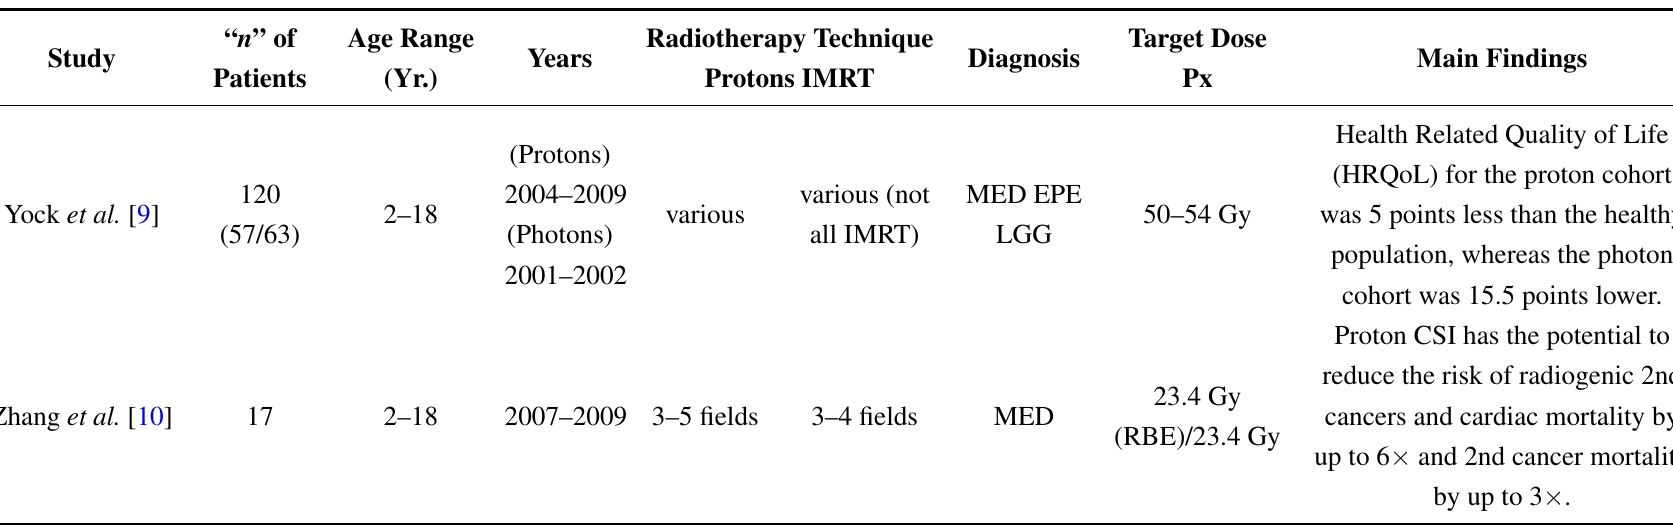
Table 1. Description of Proton versus IMRT patient outcome studies on paediatric CNS patients. [ Key: EPE—Ependymoma, LGG—Low Grade Gliomas, MED—Medulloblastoma ] .